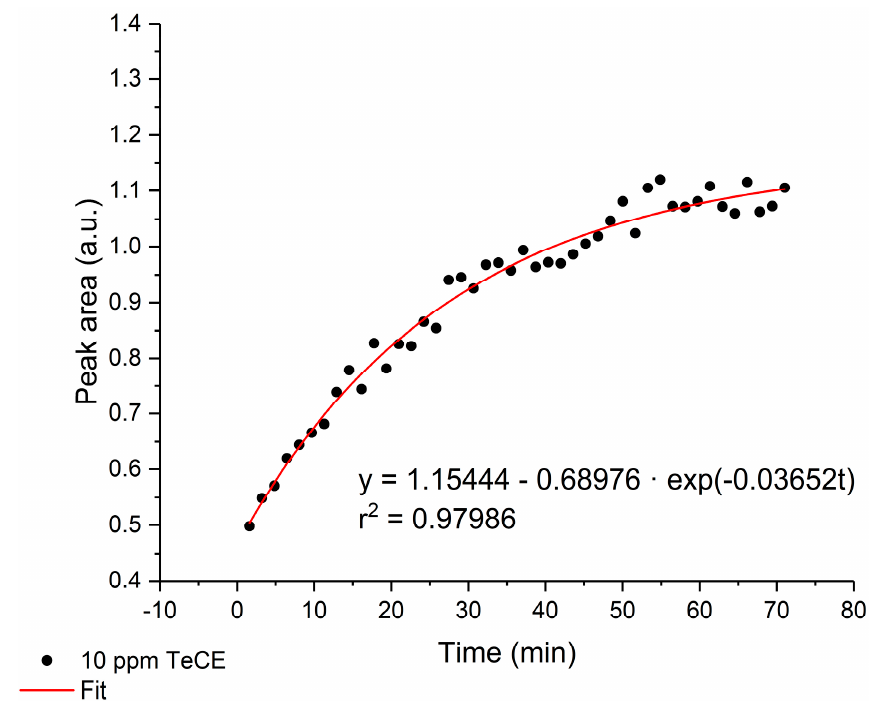
Figure 5. Exemplary diffusion curve of TeCE at a concentration of 10 ppm in an E/P-co polymer layer at 910 cm − 1 . The enrichment process was fitted with a limited growth function.